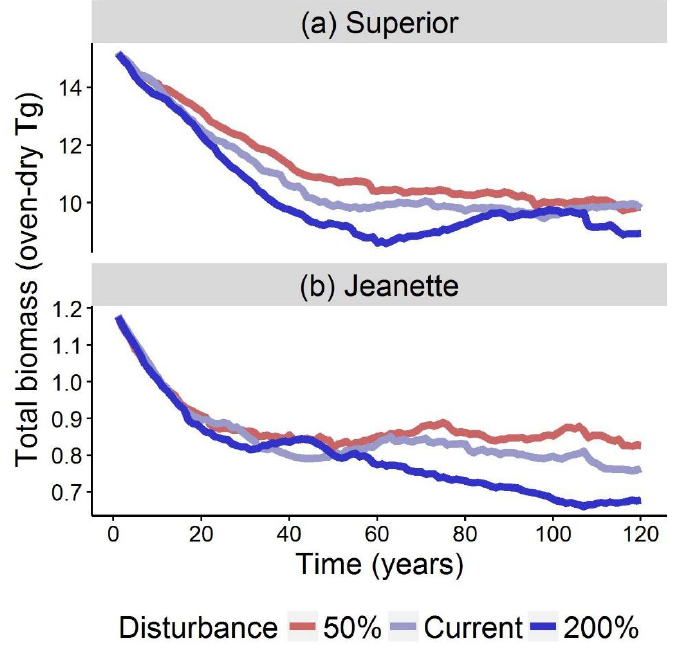
Figure 3. Simulation of total biomass stocks (including bole, tops, and branches) for the ( a ) Superior National Forest and ( b ) Jeanette Project Area using the optimized FACCS annual harvest rate and three natural disturbance scenarios. Note difference in scale in y-axis.